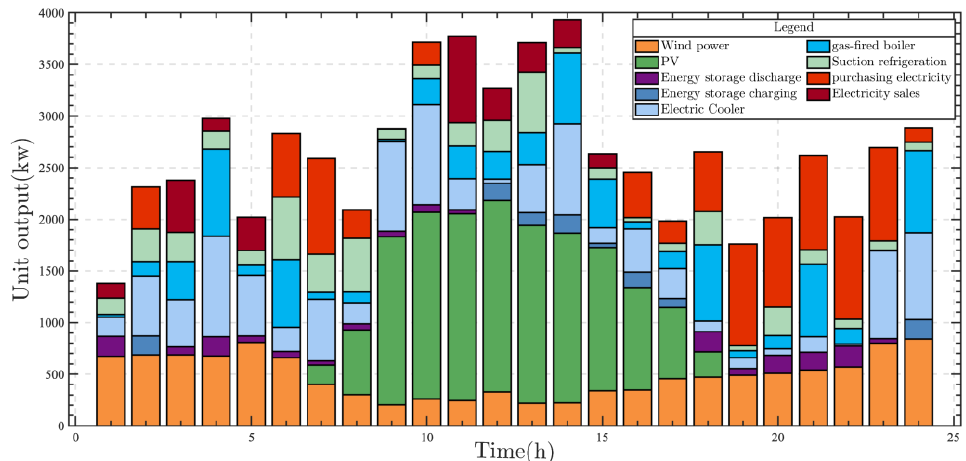
Figure 6. Volume of tradable electricity and operation of electrical units.